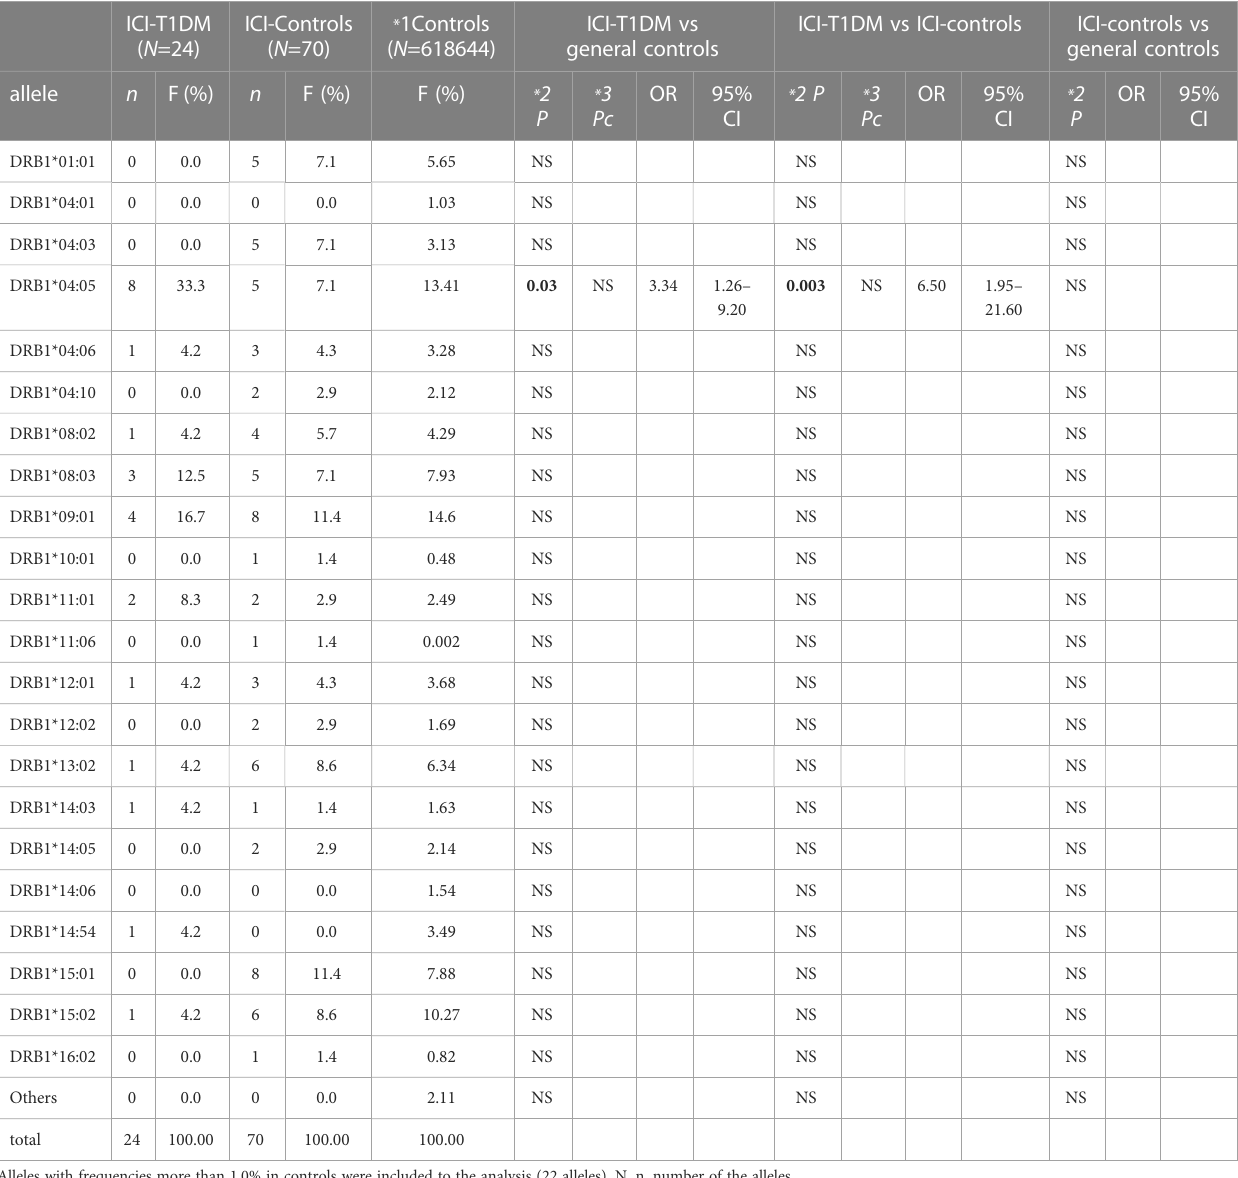
TABLE 2A Allele frequencies of HLA-DR in patients with ICI-T1DM and controls. ICI-T1DM ( N